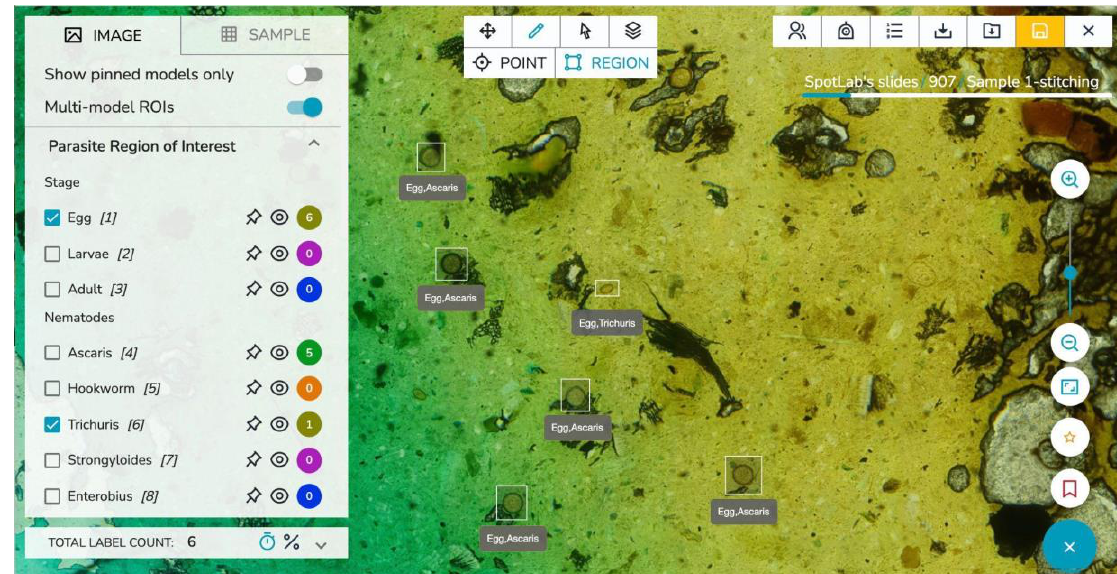
Figure 3. Screenshot of the remote telemedicine platform (developed by the authors) which allows users to navigate and zoom the image, perform annotations, quantify relevant objects and provide overall diagnostic assessments. The sample shown in this example is a Kato-Katz preparation.